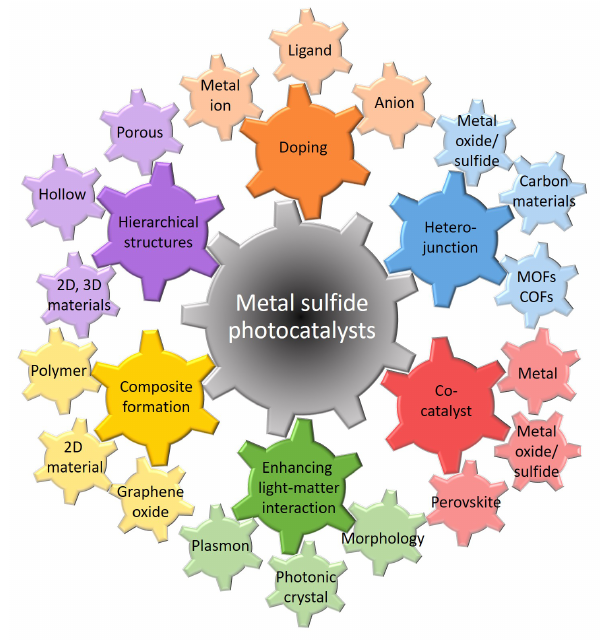
Figure 4. The most frequently employed strategies and representative components for enhancing hydrogen production over the metal sulfide photocatalysts. The figure was designed in accordance with the recent literature discussed in this